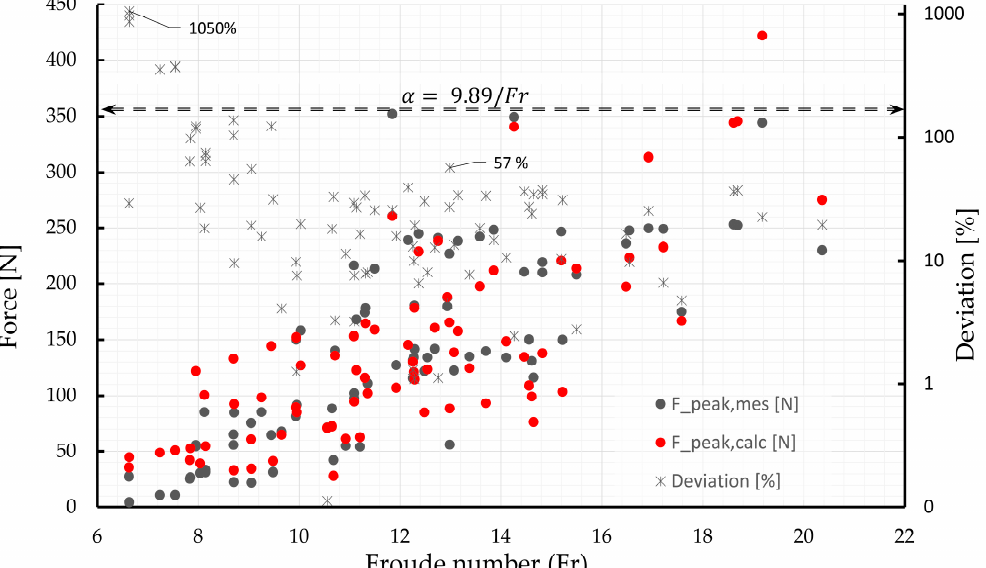
Figure 5. Comparison of the measured maximum impact force F peak,mes with the calculated impact force F peak,calc according to Equation (24) and the deviation between F peak,mes and F peak,calc . Result of the factor 𝛼 by analyzing different ranges of the Froude number using linear regression.